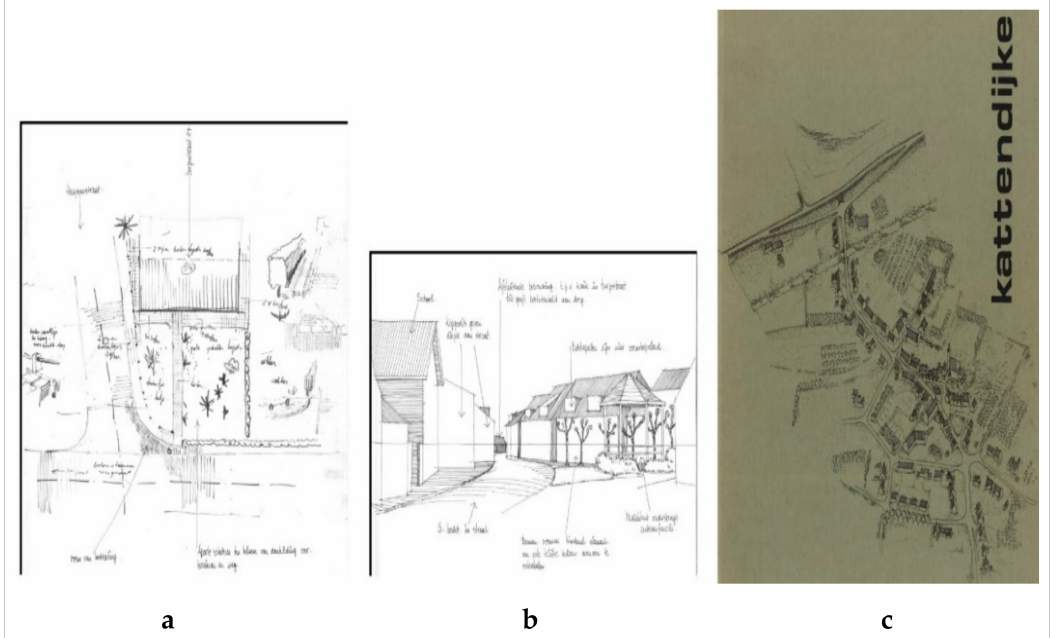
Figure 21. ( a ) Study of materials and metalling for visual analysis of small settlement “Kattendijke” [58]. ( b ) Mass-space study for visual analysis of small settlement “Kattendijke” [58]. ( c ) Visual analysis of small settlement “Kattendijke”